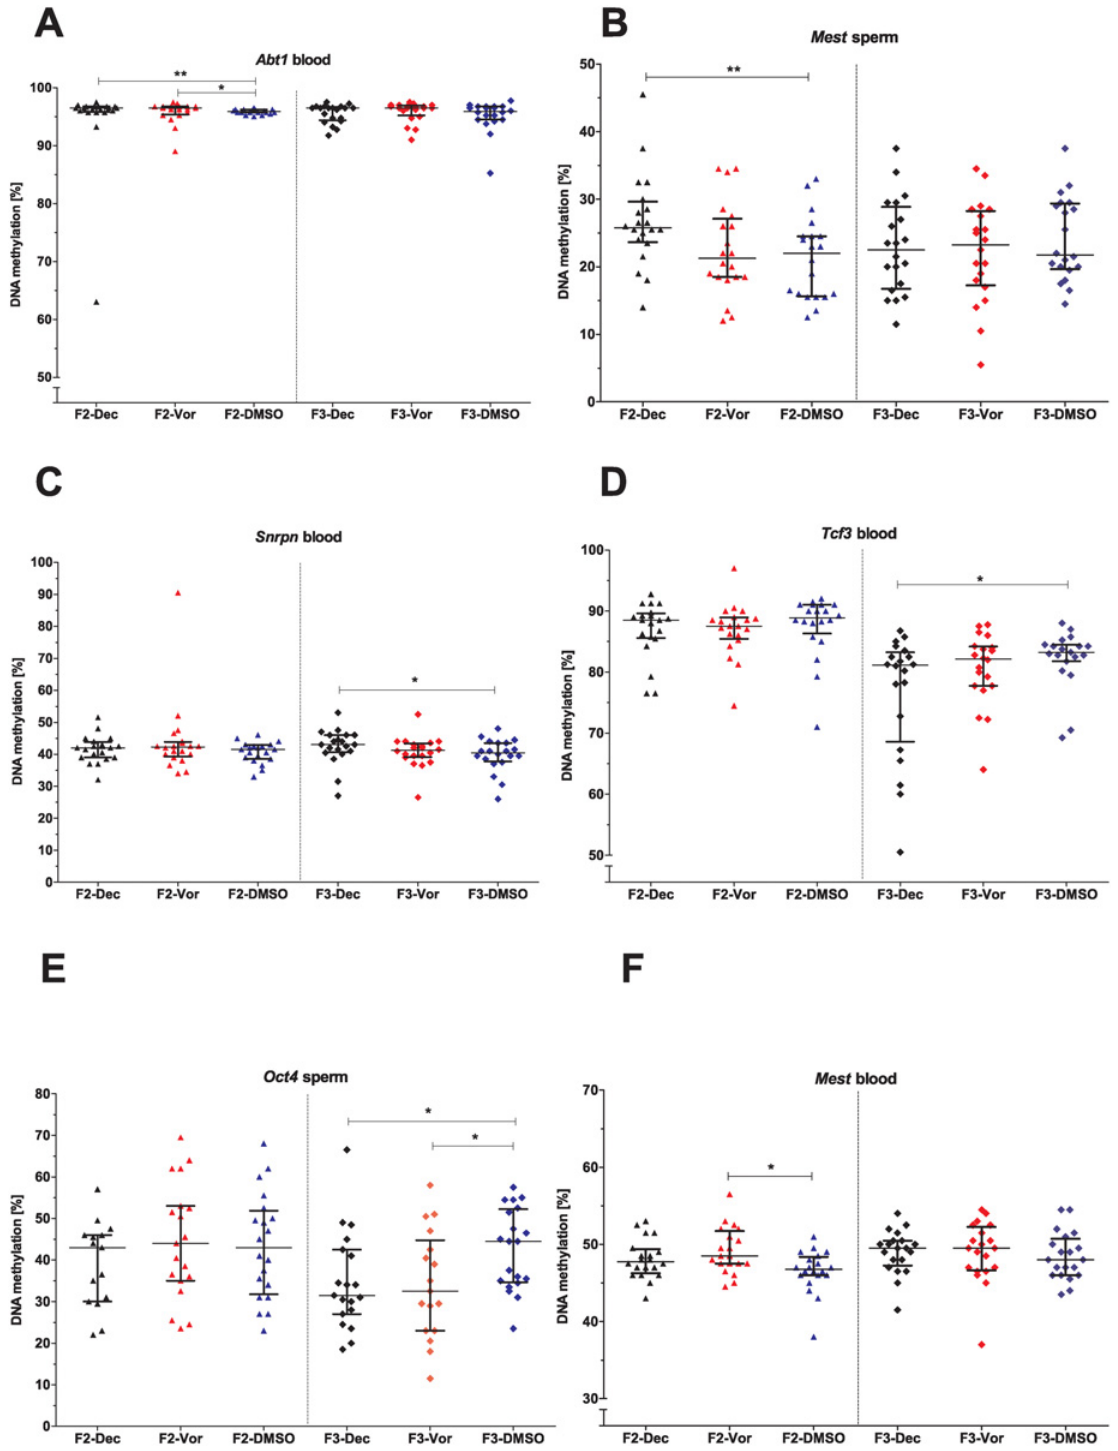
Fig 7. Transgenerational effects of decitabine and vorinostat treatment on DNA methylation levels. Genes: A) Abt1 in blood, B) Mest in spermatozoa, C) Snrpn and D) Tcf3 in blood, E) Oct4 in spermatozoa, F) Mest in blood. One point represents one animal. The median ( ± interquartile range) is shown for each group, * : p < 0.05, ** : p <